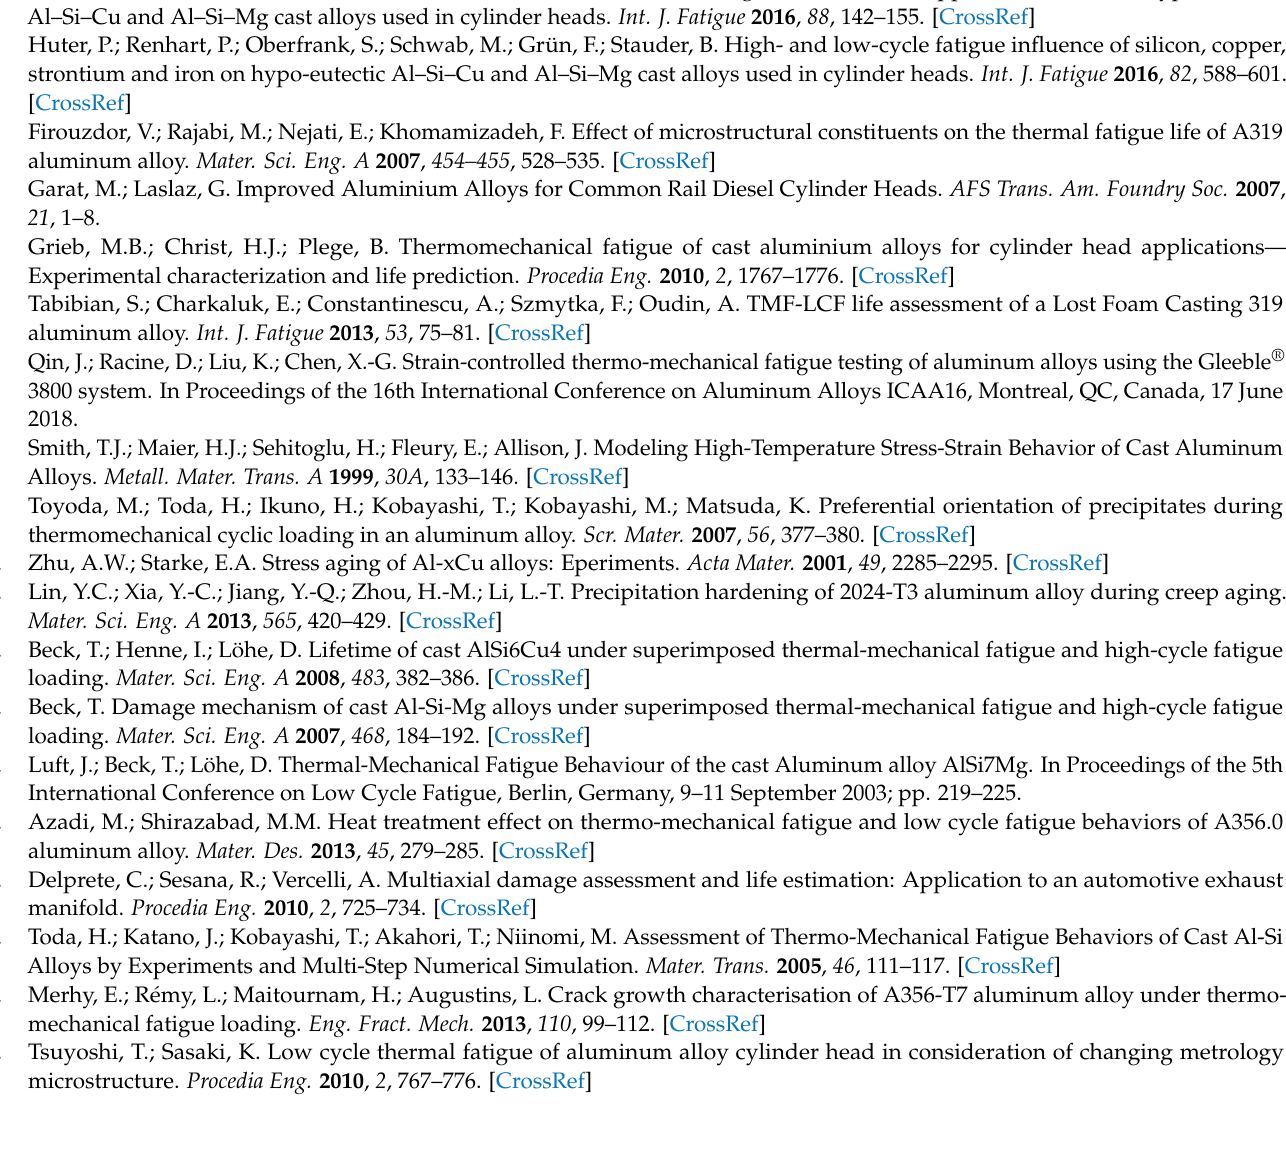
Figure A8. Z-set axisymmetric mesh of the TMF tubular specimen with the top edge: end of the jaw, and the bottom edge: as the middle of the specimen.